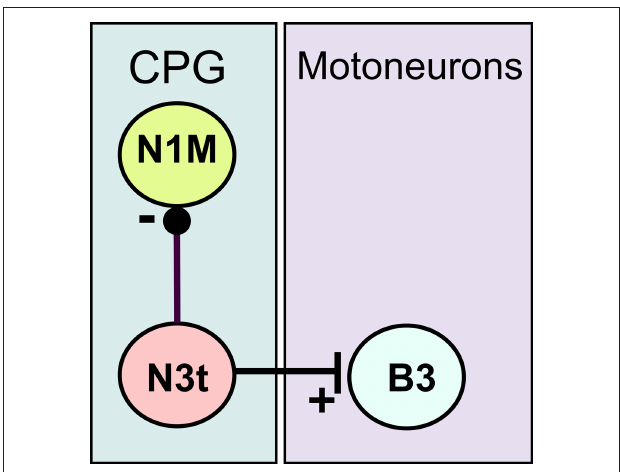
Figure 1 | Synaptic connectively of the N3t neuron. The N3t has monosynaptic inhibitory connection (black dot) with the CPG neuron, the N1M, and a monosynaptic excitatory connection (vertical bar) with the B3, a motoneuron that innervates the buccal mass. The B3 neuron is routinely recorded to monitor of N3t firing as each spike in the N3t is accompanied by 1:1 EPSPs in the B3 (Elliott and Benjamin, 1985). Tonic N3t firing inhibits activity in the N1M either completely or partially depending on the firing rate of the N3t (Staras et al.,